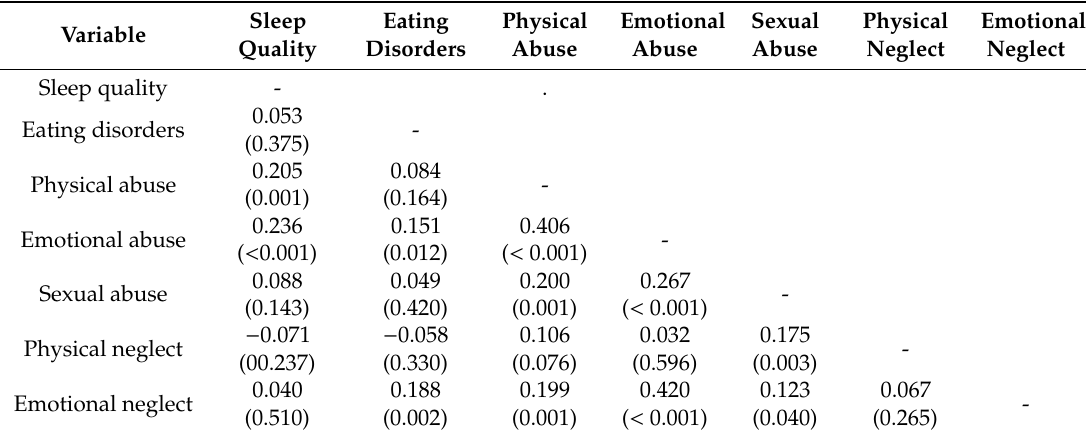
Table 3. Correlations of Study Variables ( n =